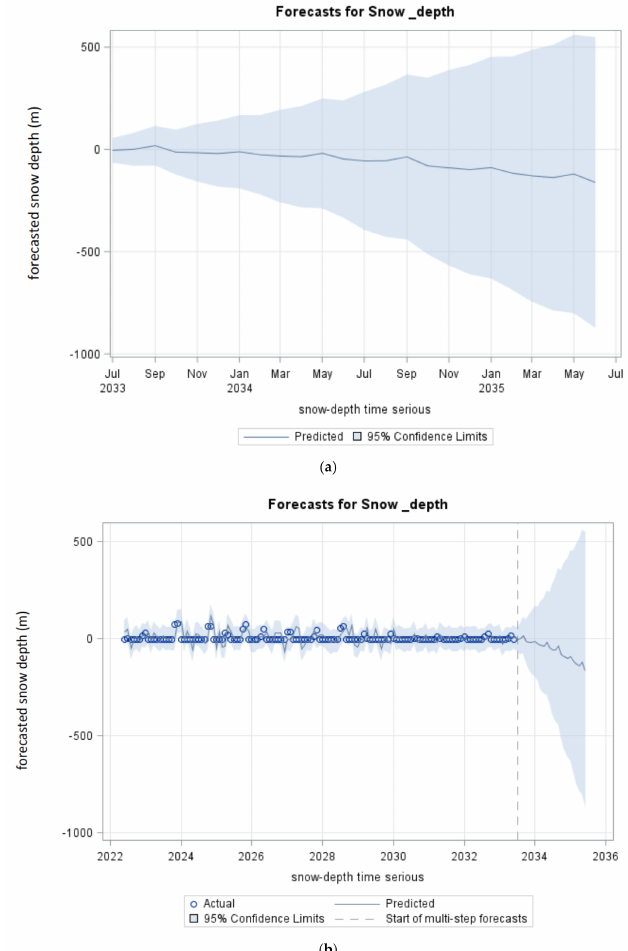
Figure 12. ARIMA analysis for the snow-depth forecast over time from the Vaasa airport weather station. In the figure − 500 or − 1000 = minus 500 or minus 1000. ( a ) shows forecast in snow depth since 2033 up to 2035. ( b ) shows forecast in snow depth from 2022 to 2036.